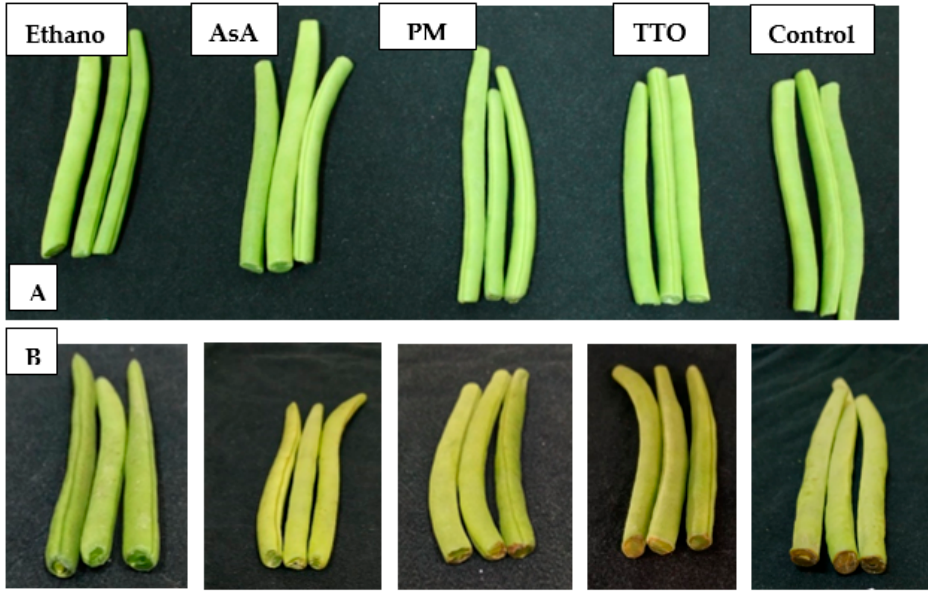
Figure 3. Green bean samples treated with ethanol, AsA, PMO, TTO, and control after ( A ) 3 d and ( B ) 15 d of storage at 5 °C. ( B ) 15 d of storage at 5 ◦